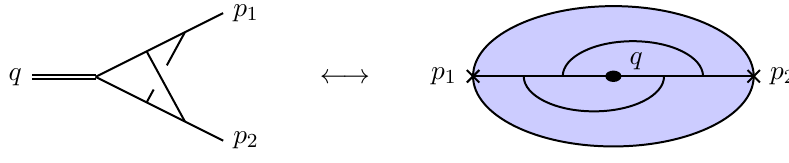
Figure 4. A non-planar Feynman diagram which appears as planar when drawn on a punctured disk. All such diagrams contribute to the large N form